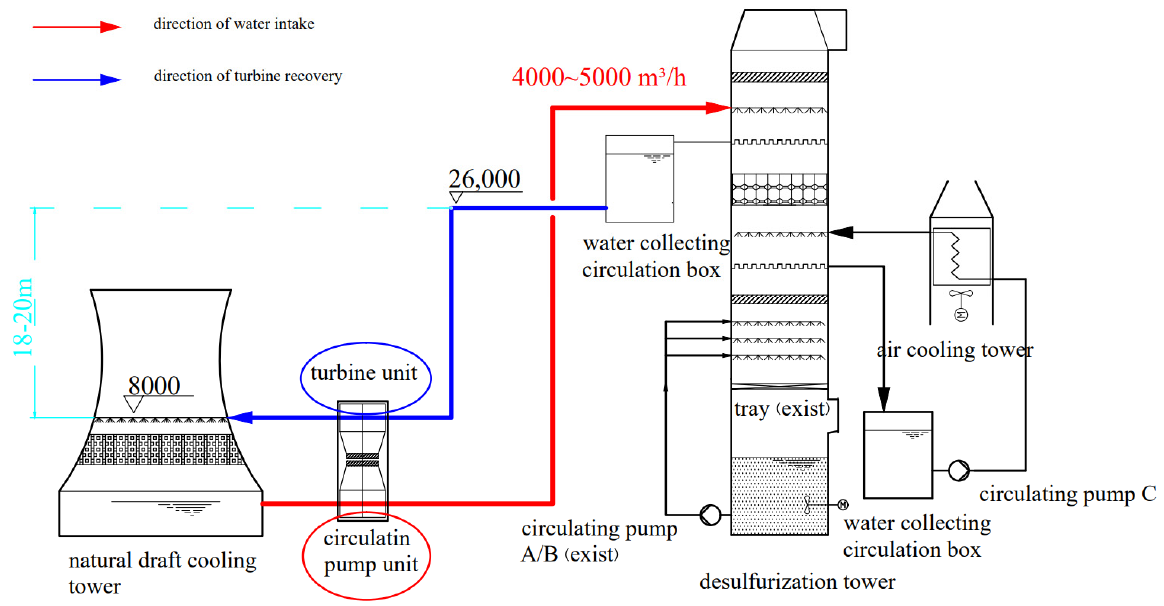
Figure 1. Turbine in desulfurization tower.